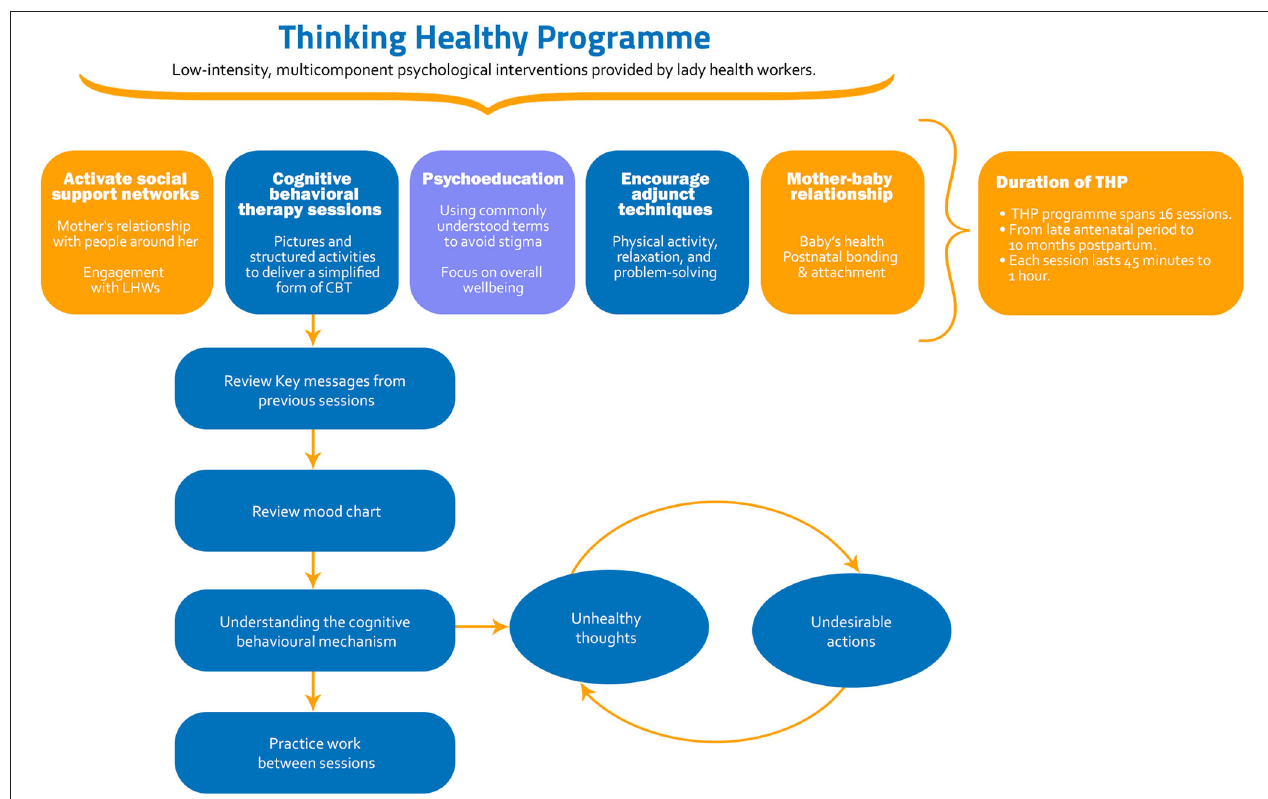
FIGURE 1 | Content of the thinking healthy programme.